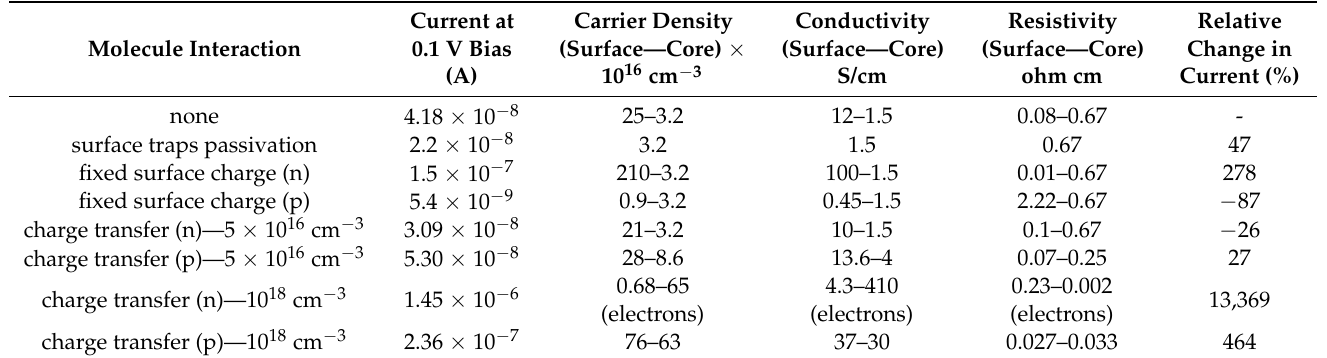
Figure 9. Carrier density plotted as function of density of transferred charge considering holes (blue open symbols) and electrons (red open symbols) on the surface on the NW and holes (blue filled symbols) and electrons (red filled symbols) in the core on the NW. Lines are guide for the eye. Table 1. Calculated parameters for different sensing processes